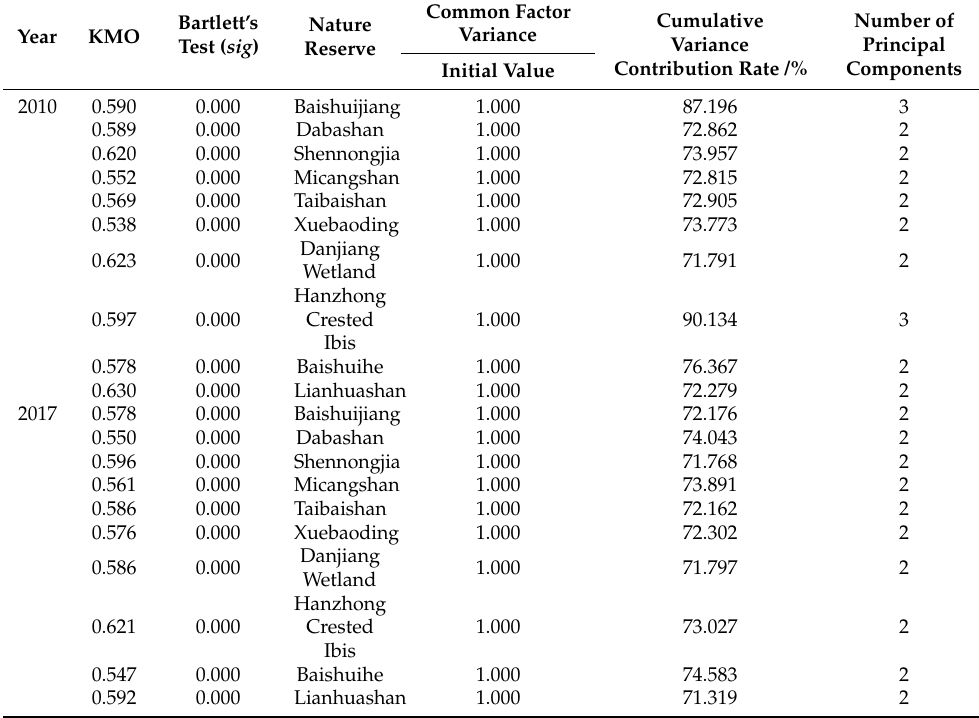
Table 1. Results of principal component analysis of landscape indices.